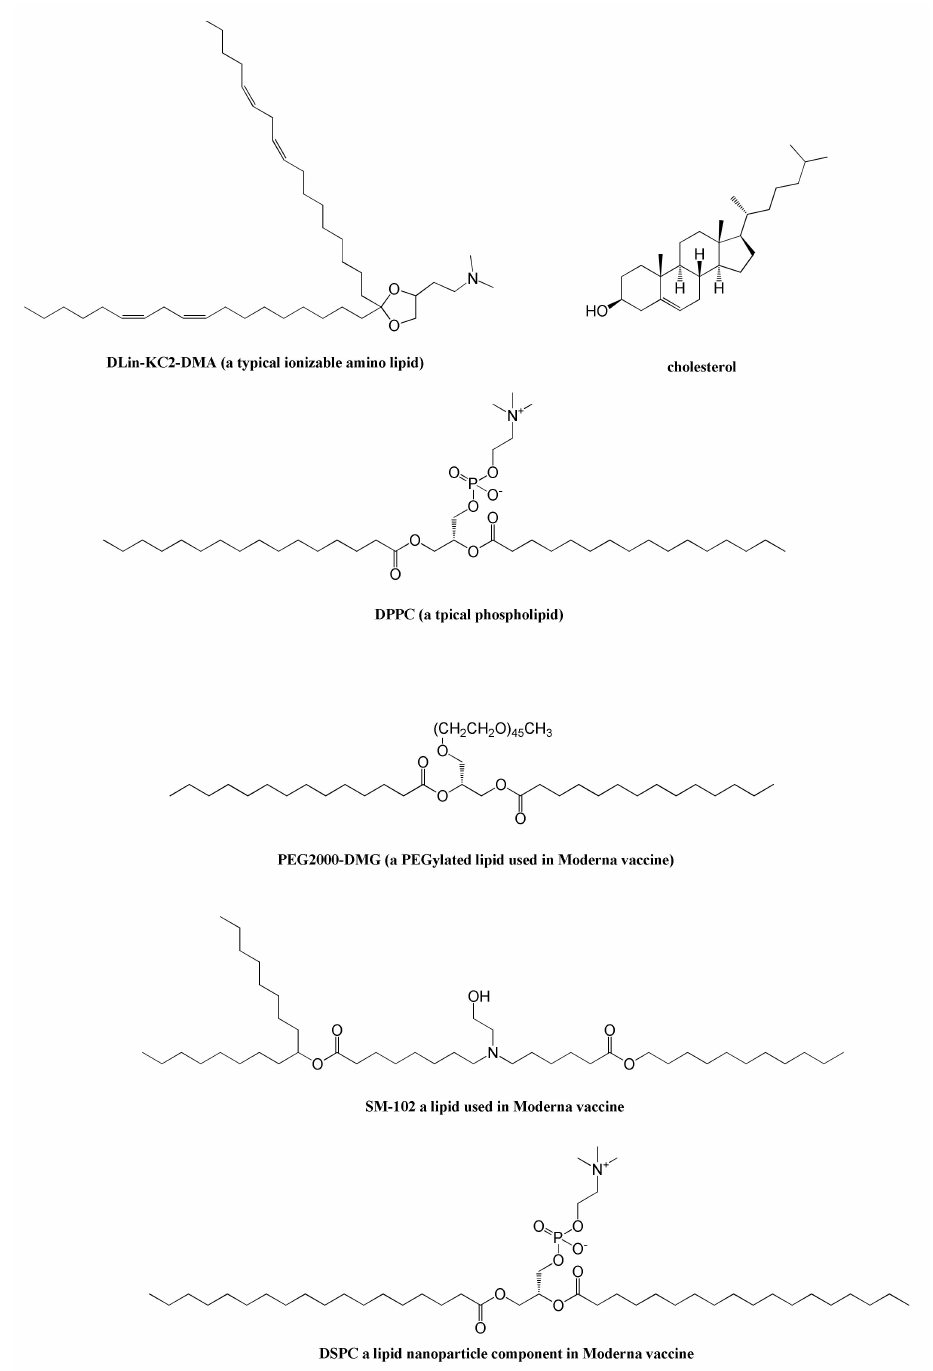
Figure 2. Chemical representations of some typical components of lipid nanoparticles as well as specific components of the Moderna vaccine. DPPC: dipalmitoylphosphatidylcholine; DSPC: